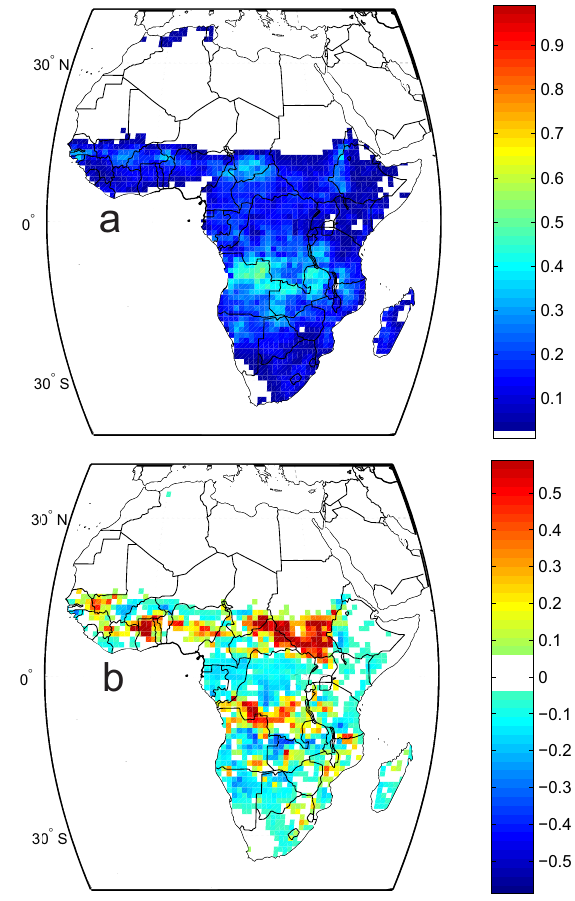
Fig. A1. Fraction of area burned in the fire year 2007. Panel (a) predicted from the parameterised fire model C. Panel (b) residuals observed (remotely sensed from MODIS MCD45; see Fig. 4a) – predicted from model C. Data for the year 2007 is not used for the estimation of the model parameter (Table